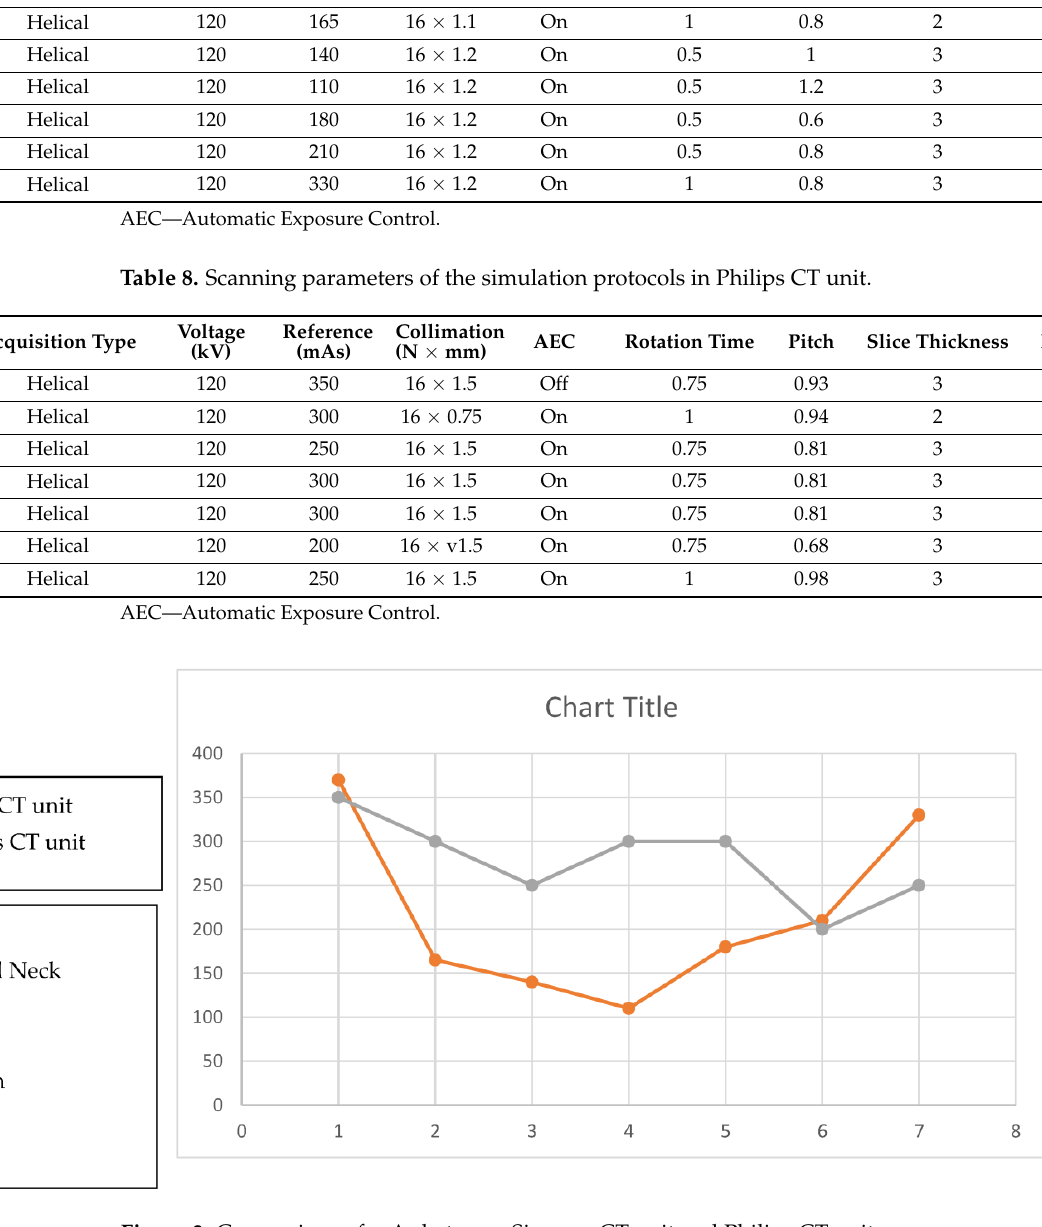
Figure 3. Comparison of mAs between Siemens CT unit and Philips CT unit.